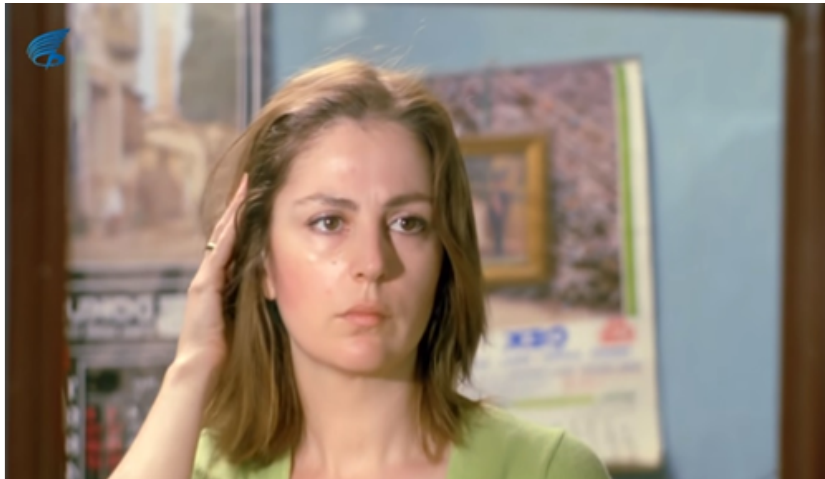
Figure 3 : Aygül looks in the